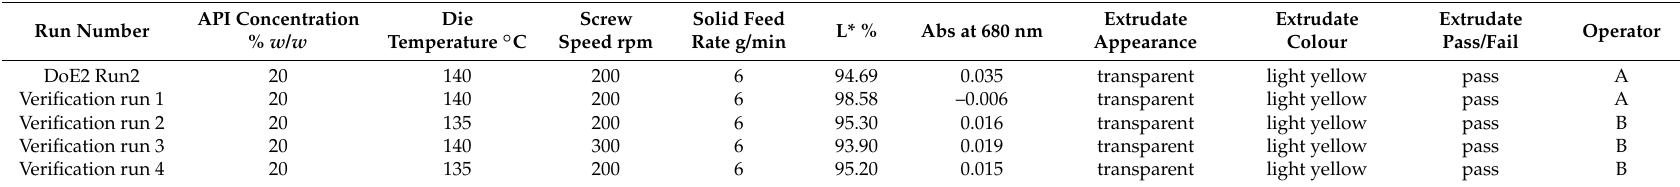
Table 7. Process Conditions Verification